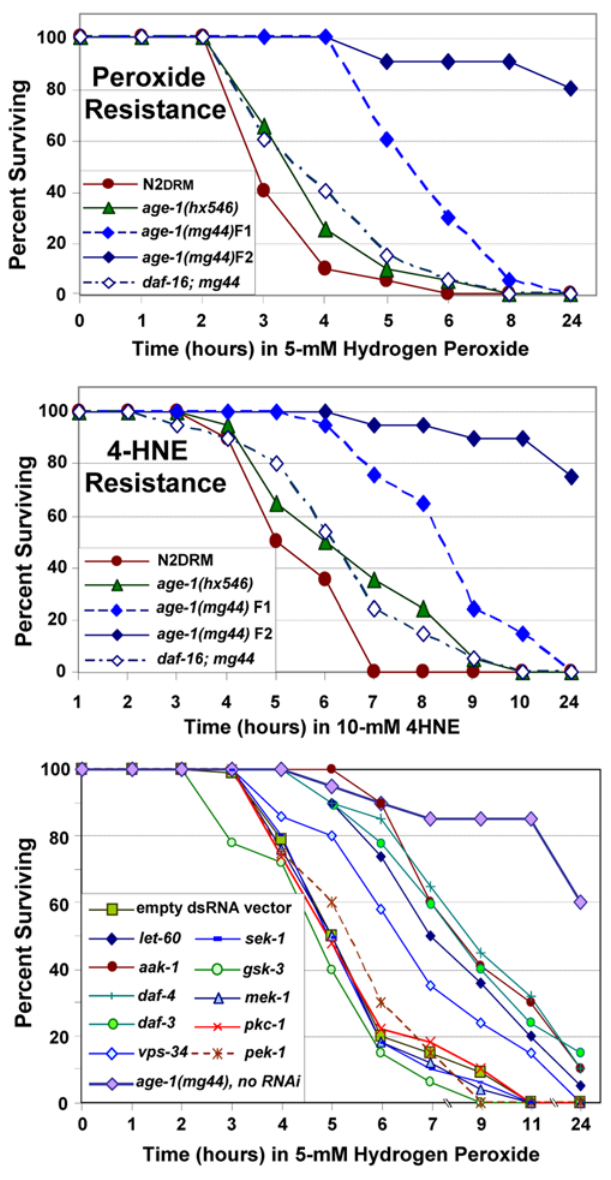
Figure 5. Survival of oxidative and electrophilic stresses. N2DRM worms were exposed to (A) 5-mM hydrogen peroxide (H 2 O 2 ), or (B) 10-mM 4-hydroxynonenal (4-HNE). Stress survivals began on adult day 3–4 and worms were maintained in liquid medium, 20 6 0.3 u C, without bacteria. Results shown were replicated in independent experiments. Statistics (log-rank test, each n =40–50, both A and B): age-1(mg44) at F2 vs. F1 generation: P , 10 2 7 ; age-1(mg44) F1 vs. any other strain: P , 10 2 3 ; age-1(mg44) F2 vs. any other strain or group: P , 10 2 9 ; age-1(hx546) vs. N2DRM: P , 0.004; daf-16(mu86); age-1(mg44) vs. N2DRM: P , 0.005. (C) Functional consequences of